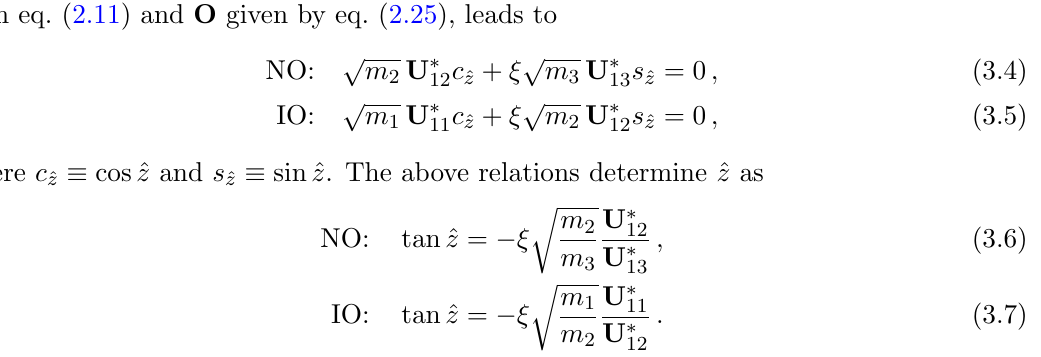
= j (cid:1) m 2 j . 21 31 and M , the constraint ( e Y ) = 0 together (cid:23) 11 R ‘